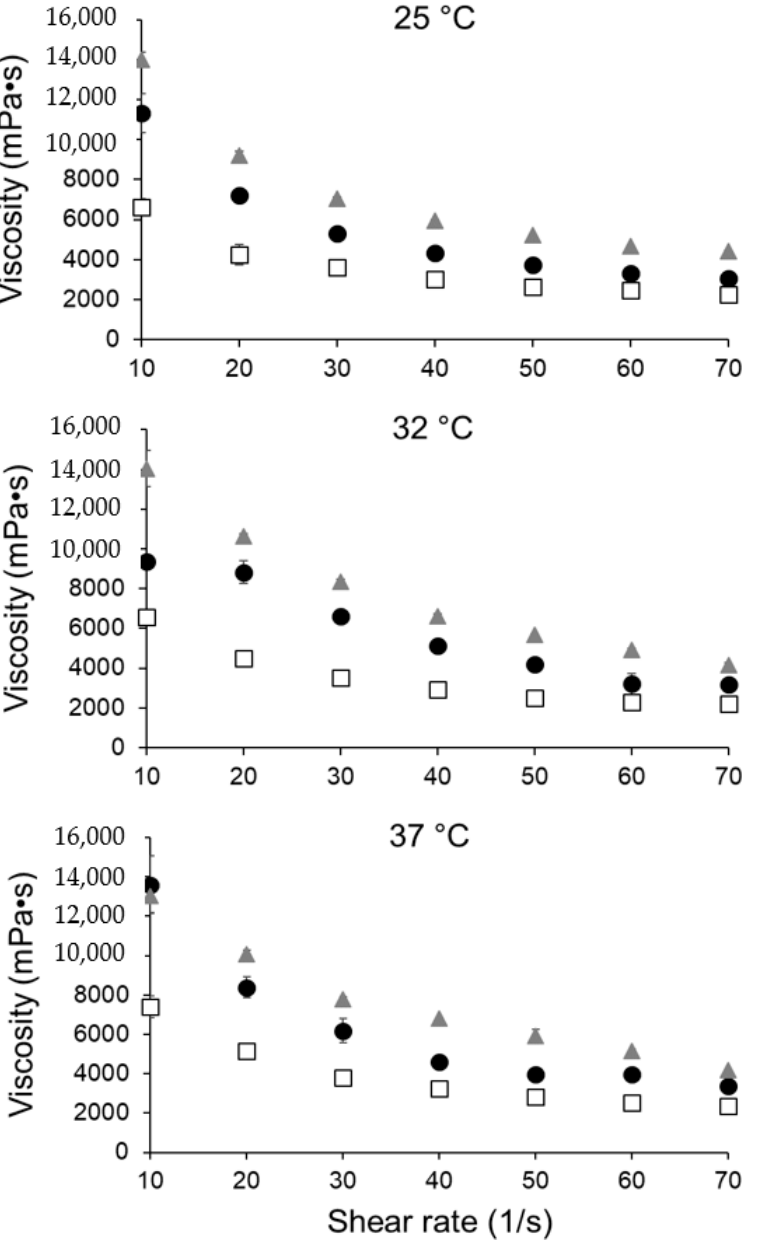
Figure 2. Viscosity of PEITC carbomer gel (gray triangles), blank carbomer gel (white squares), and commercially available Alocane gel (black circles) at 25, 32, and 37 °C. All samples run in trip- licate.